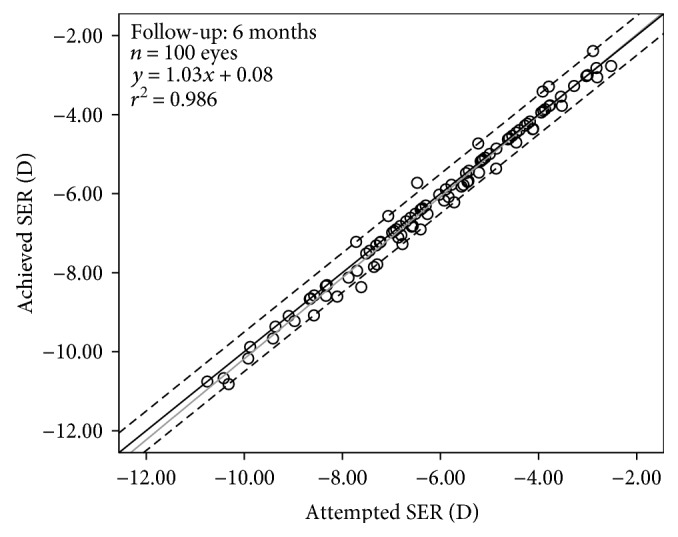
Predictability of spherical equivalent refraction (SER) at 6 months postoperatively. The area between two dotted lines is the postoperative SER within ±0.50 D. The solid grey line represents linear regression.